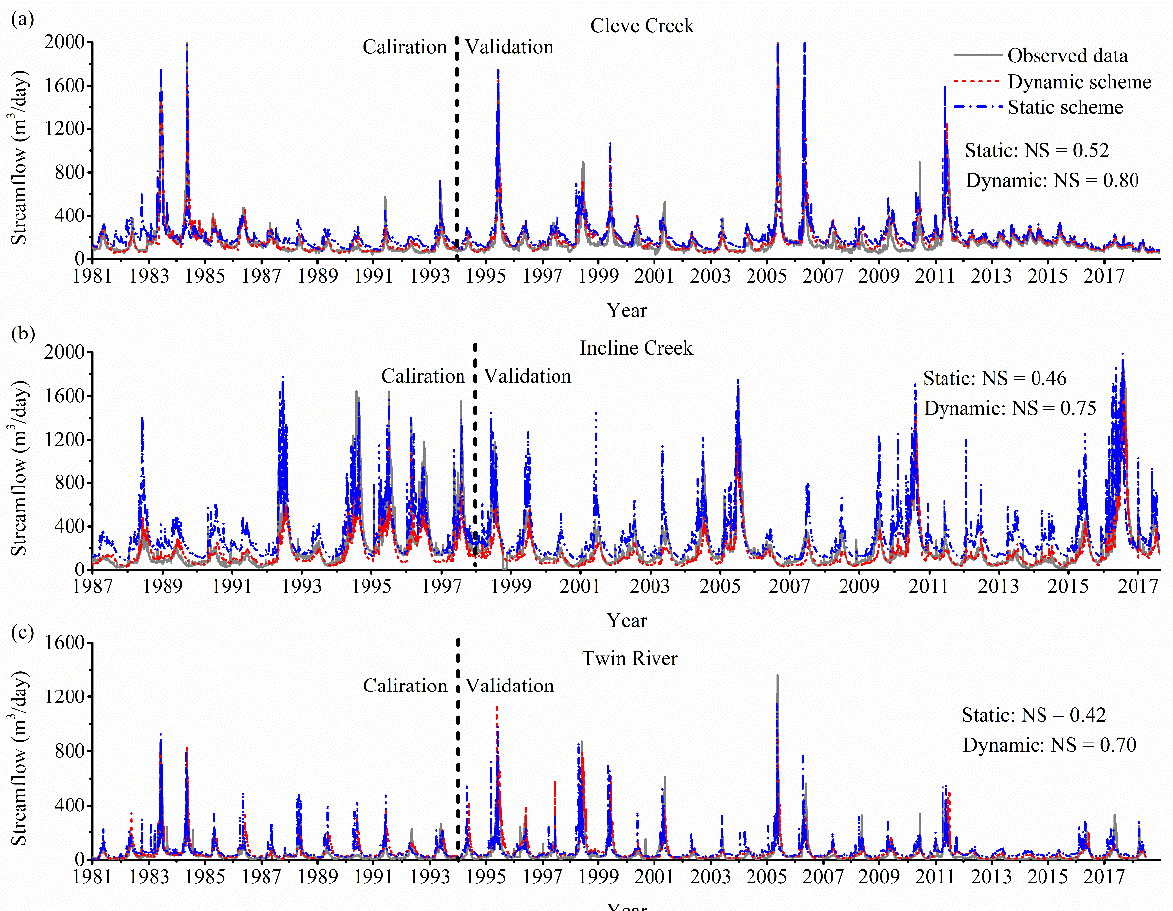
Figure 6. Observed streamflow and simulated streamflow under dynamic and static scheme in ( a ) Cleve Creek, ( b ) Incline Creek, and ( c ) Twin River watersheds.